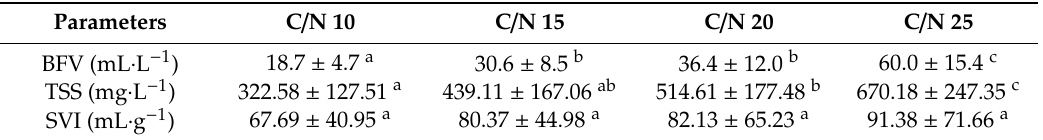
Table 2. Bioflocs parameters (bioflocs volume (BFV), total suspended solids (TSS), sludge volume index (SVI)) in di ff erent C / N